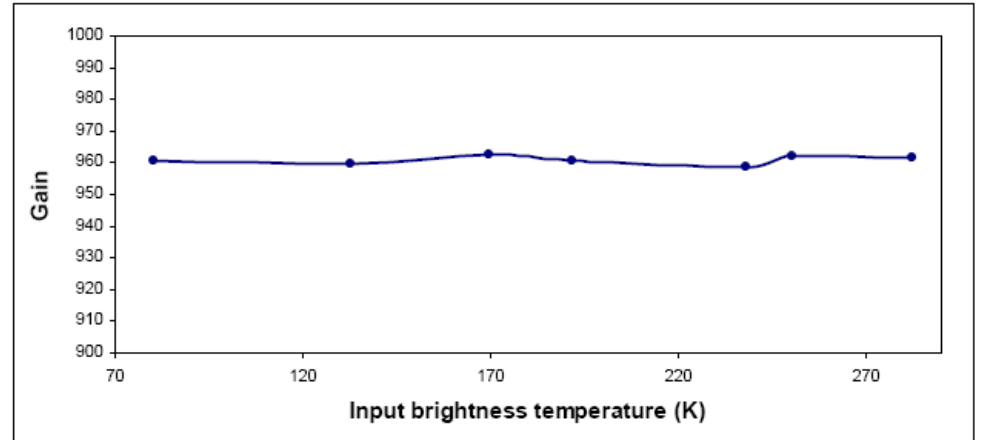
Figure 4. Illustration of CAROLS receiver